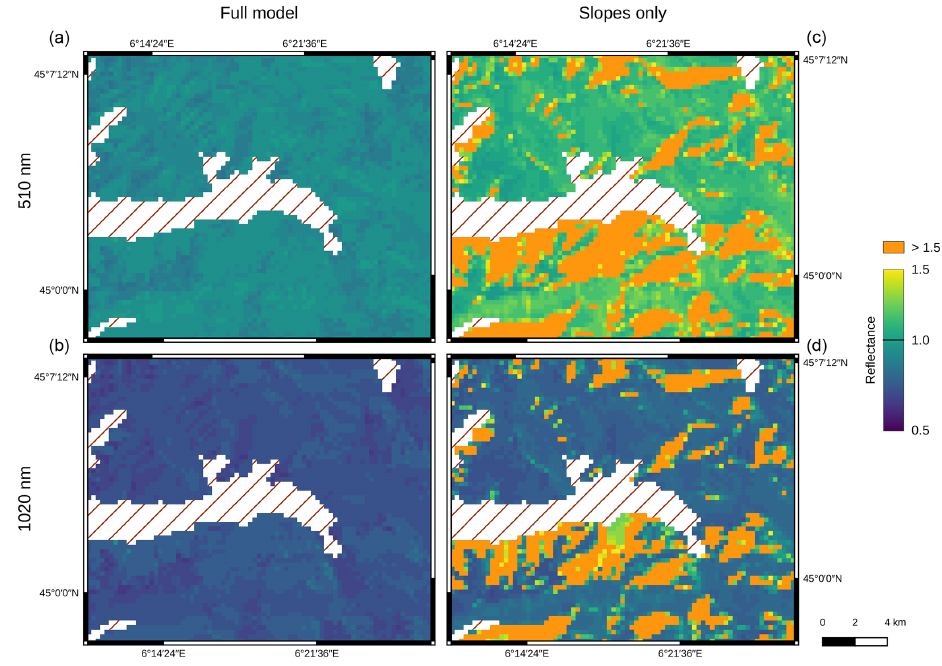
Figure 10. Modelled surface reflectance using the full-rugged-terrain (a, b) and slope-only (c, d) formulations on 13 February 2018 at 510nm (a, c) and 1020nm (b, d) . Pixels containing less than 80% of snow were masked out (hatched region).